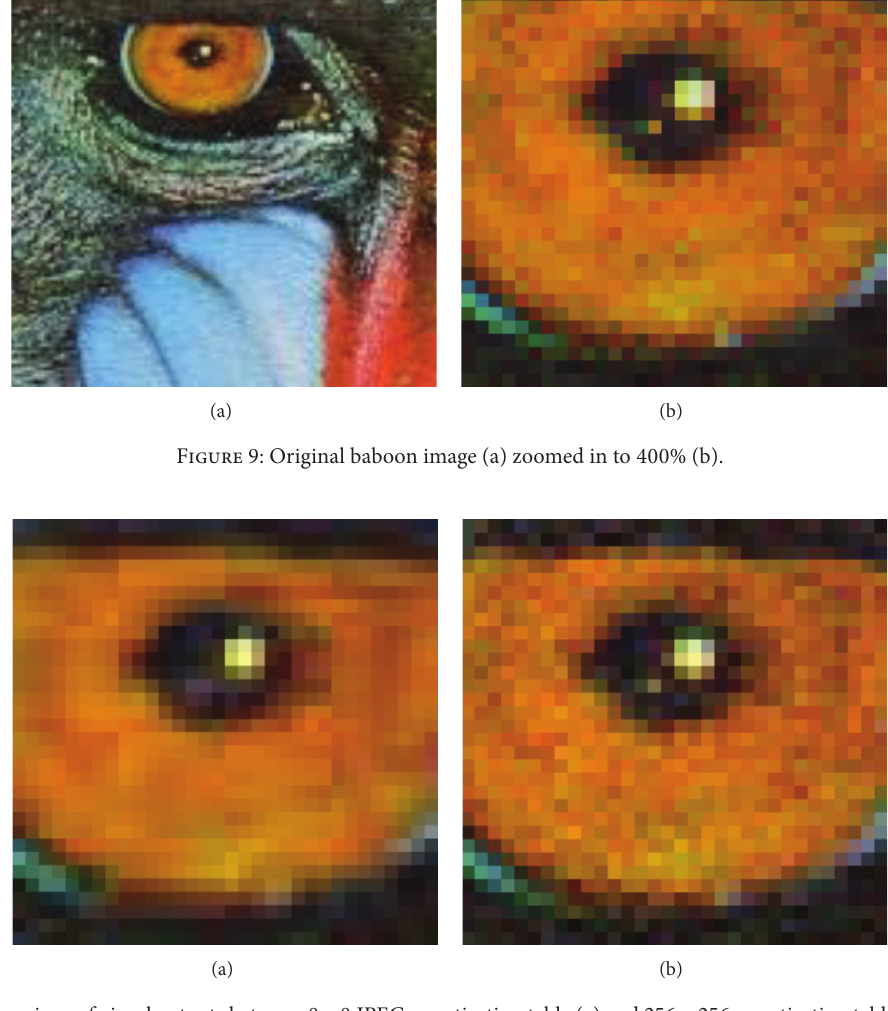
Figure 10: The comparison of visual outputs between 8 × 8 JPEG quantization table (a) and 256 × 256 quantization tables from psychovisual threshold (b) zoomed in to